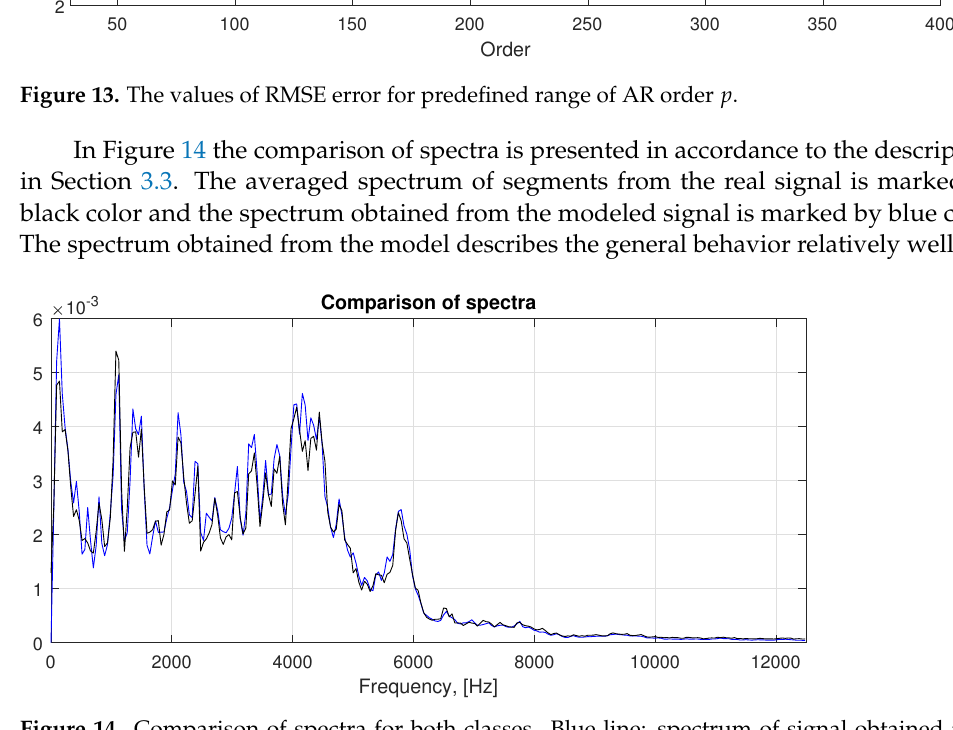
Figure 14. Comparison of spectra for both classes. Blue line: spectrum of signal obtained from averaged autoregressive (AR) coefficients. Black line: averaged spectrum of segments from real